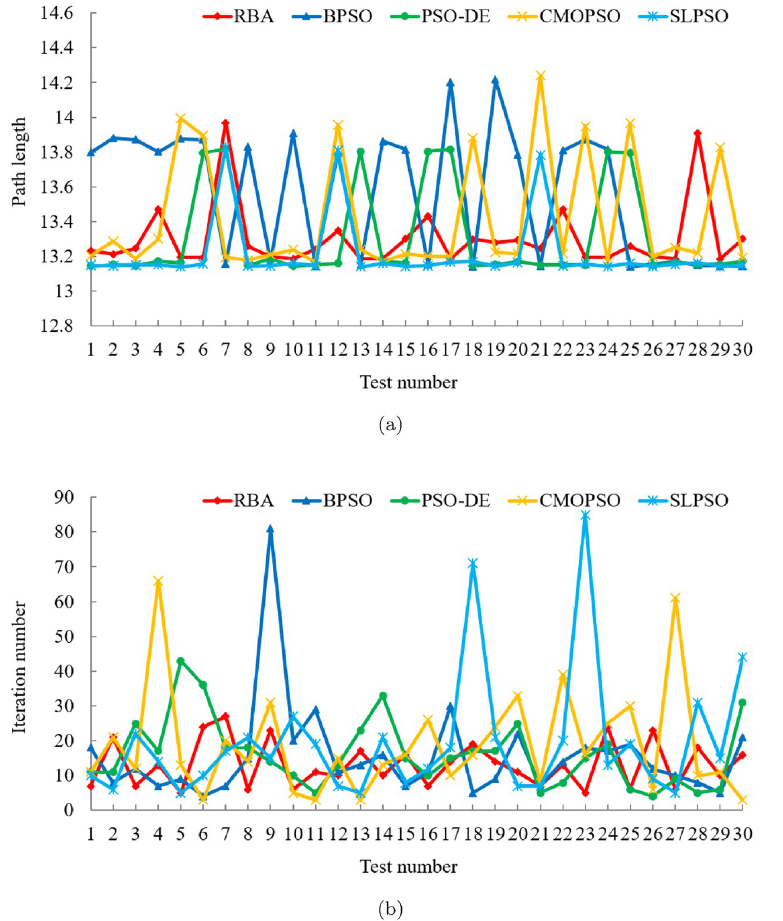
Fig 3. Experimental results of five algorithms in test case 1. (a) Path length. (b) Iteration number.